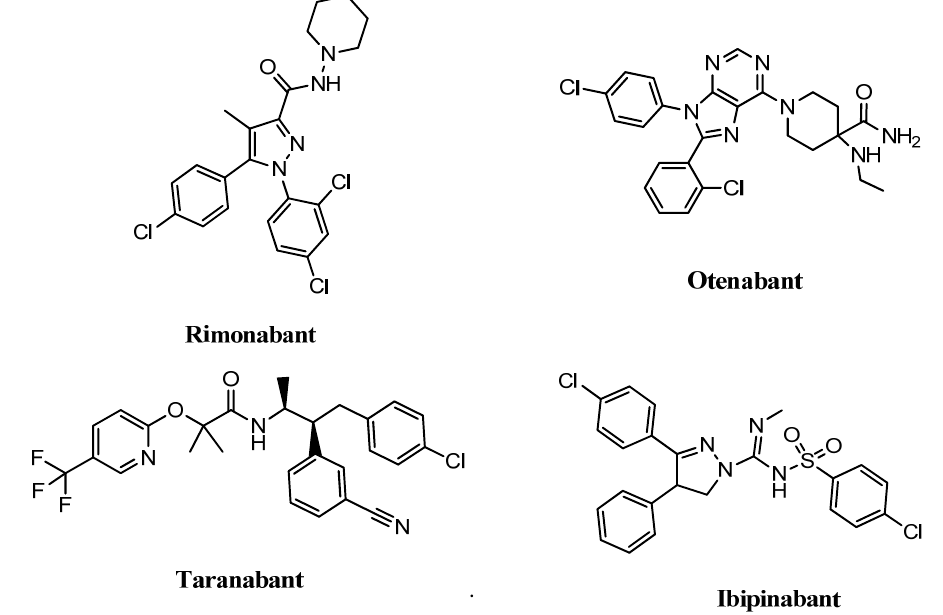
Figure 1. The type-1 cannabinoid receptor (CB1) antagonists: Rimonabant, taranabant, otenabant and ibipinabant.